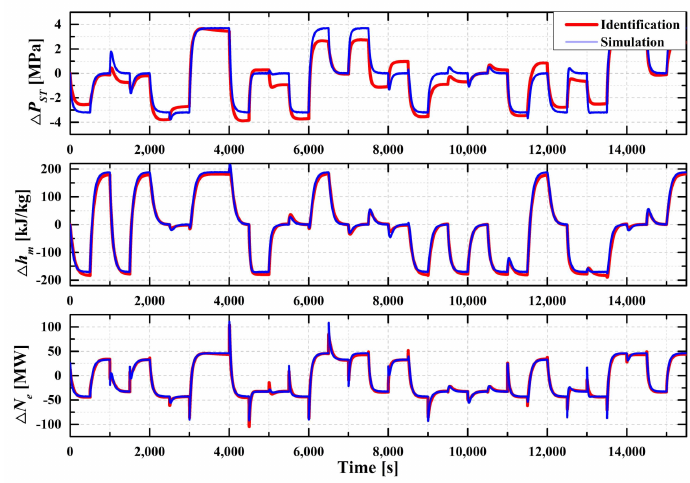
Figure 7. Identification result with inverse M sequence under the BMCR working